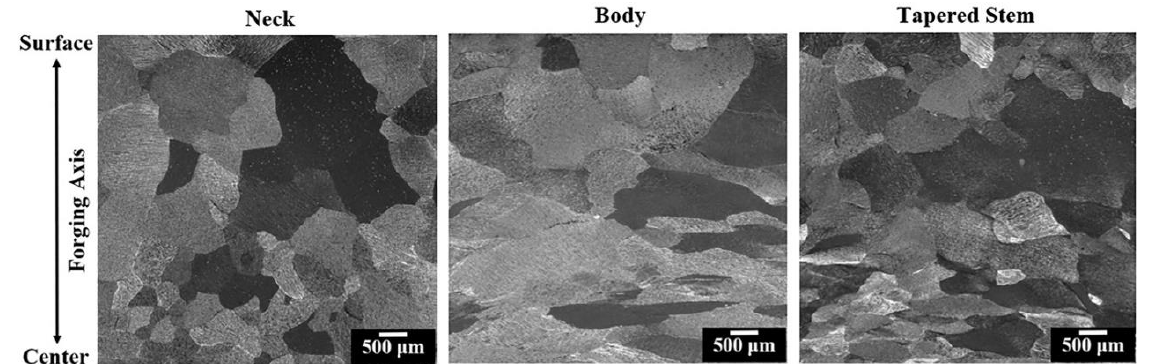
Figure 8. Digital micrograph showing the grains size and morphology of the prior β-grain of the as-DPF femoral stem at the three locations.